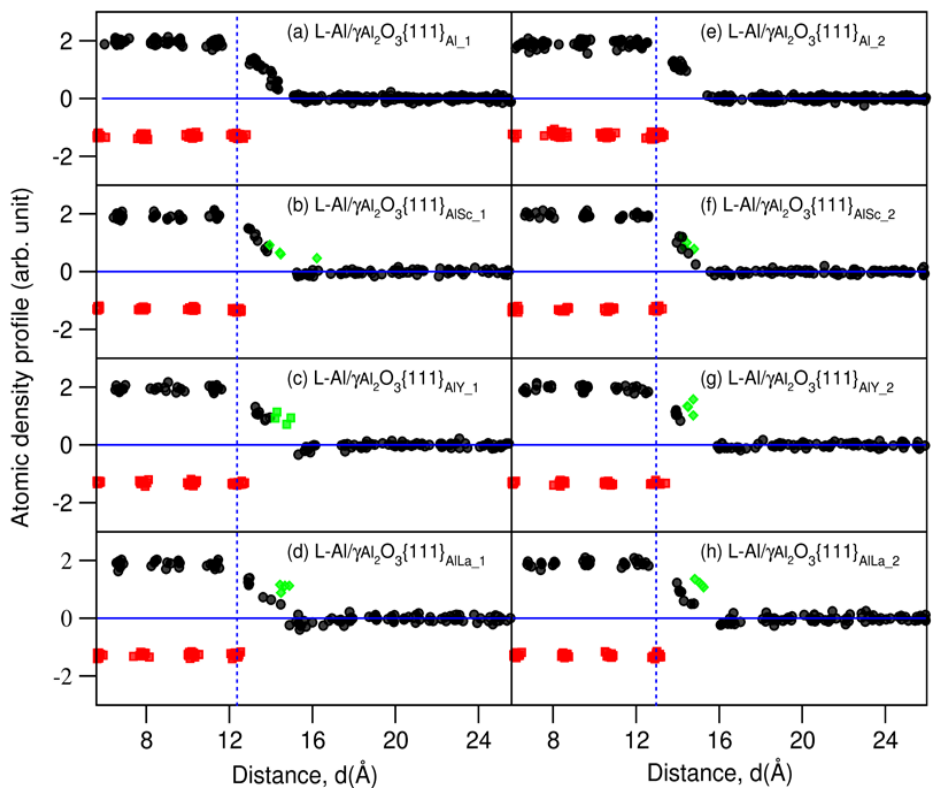
Figure 7. Charges at the atomic sites at the Al( l )/ γ -Al 2 O 3 {1 1 1} AlM interfaces including the authentic ones for comparison. Black spheres represent charges at Al sites, red squares at O and green diamonds at M sites. The constant valence values of the O ions relate to its high electronegativity. The charges at the Group 3 atomic sites are higher than those of Al at the same distances to the outmost Al. ( a ) Al( l )/ γ -Al 2 O 3 {111} Al_1 , ( b ) Al( l )/ γ -Al 2 O 3 {111} AlSc_1 , ( c ) Al( l )/ γ -Al 2 O 3 {111} AlY_1 , ( d ) Al( l )/ γ -Al 2 O 3 {111} AlLa_1 , ( e ) Al( l )/ γ -Al 2 O 3 {111} Al_2 , ( f ) Al( l )/ γ -Al 2 O 3 {111} AlSc_2 , ( g ) Al( l )/ γ -Al 2 O 3 {111} AlY_2 , ( h )